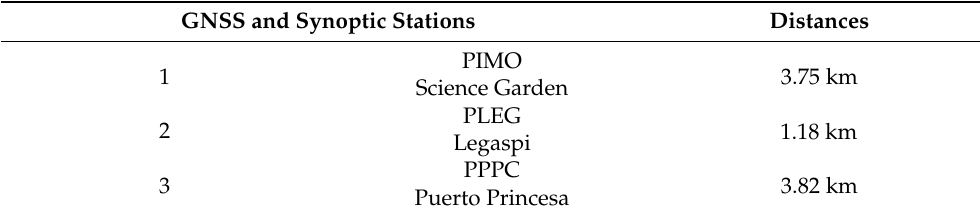
Table 2. The distances of the GNSS stations to their collocated weather stations selected in this study. GNSS and Synoptic